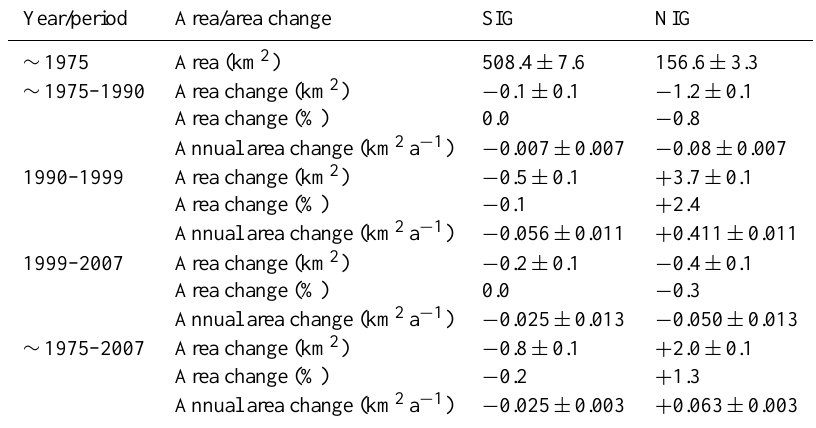
Table 3. The SIG and NIG area change between ∼ 1975 and 2007.